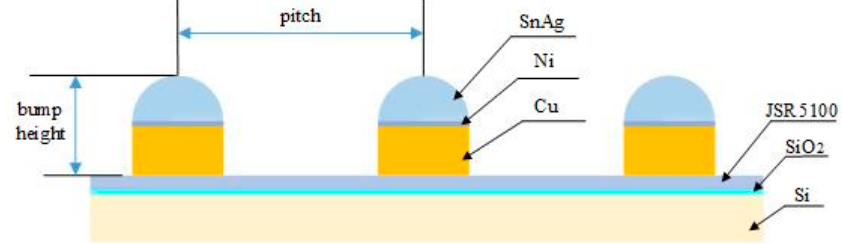
Figure 1. The measuring principle of triangulation.